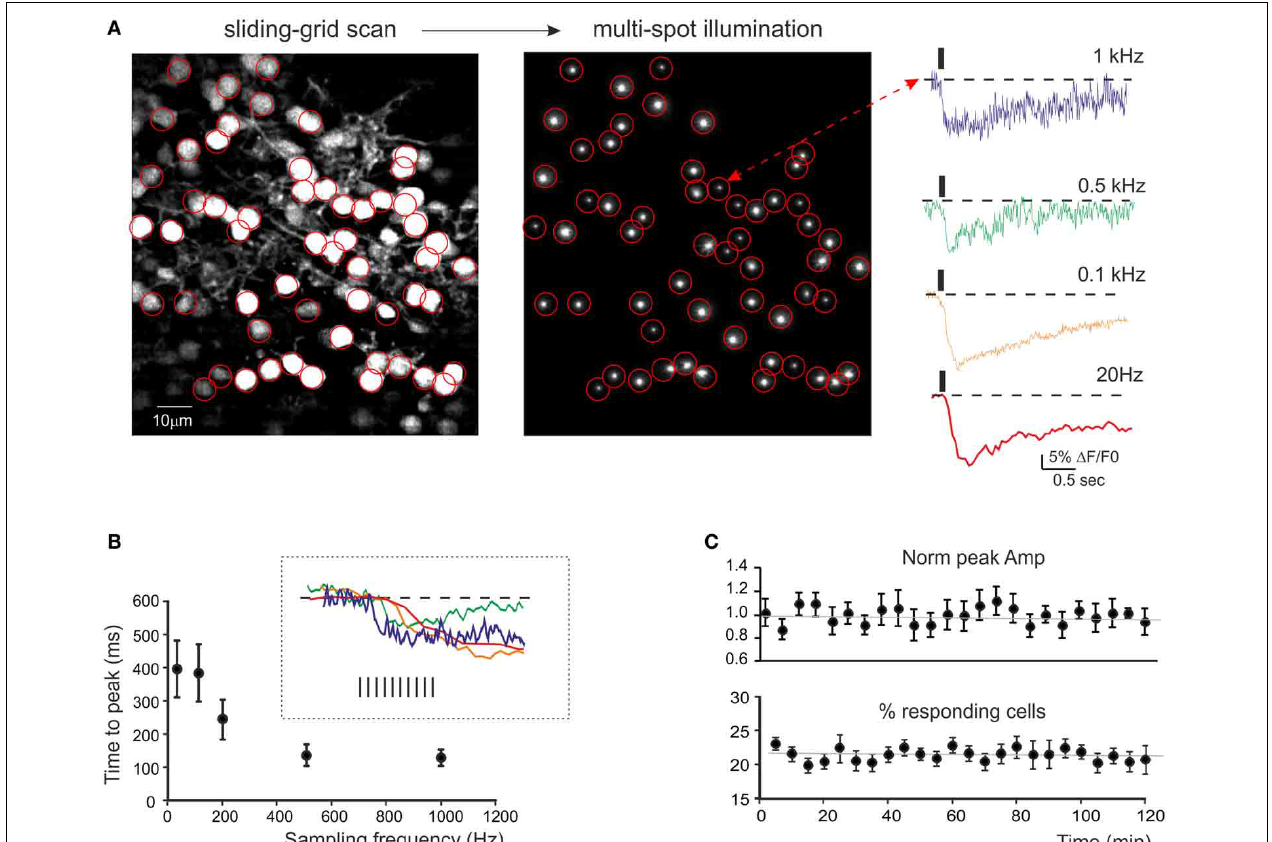
FIGURE 2 | Calcium signals from cerebellar GrCs. (A) SLM-2PM image generated by Fura-2AM bulk loading of a cerebellar slice illuminated with sliding grid scan and reconstructed on-line. Multi-spot illumination was generated by pointing the laser beamlets toward selected neurons. The Ca 2 + signal variations detected from the soma of GrCs in response to mossy fiber stimulation (10 impulses at 50Hz) appear as a (cid:3) F/F 0 reduction induced by intracellular calcium increase in GrCs. The traces on the right show the time course of (cid:3) F/F 0 at different sampling frequencies (up to 1kHz) taken from a representative GrC. It should be noted that calcium signals show faster